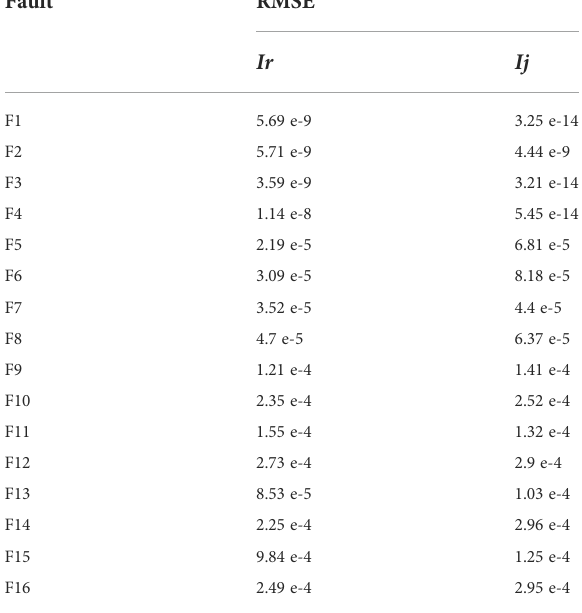
TABLE 3 RMSE of GDEM for the PV PGs. Fault RMSE Ir